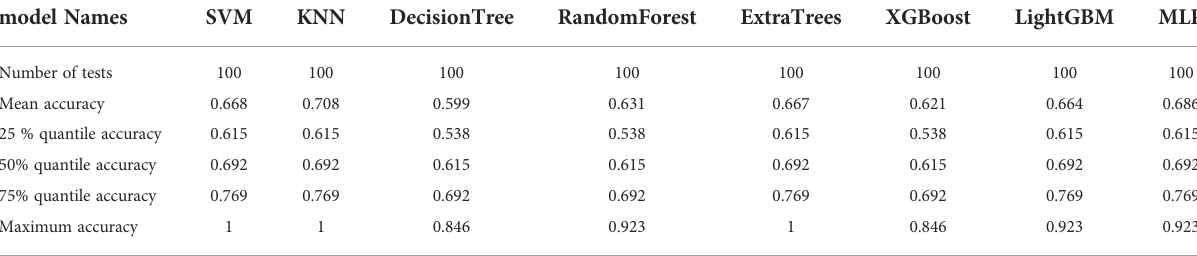
TABLE 6 Distribution of the accuracy of each model randomly tested 100 times by eight common machine learning algorithms. model Names SVM KNN